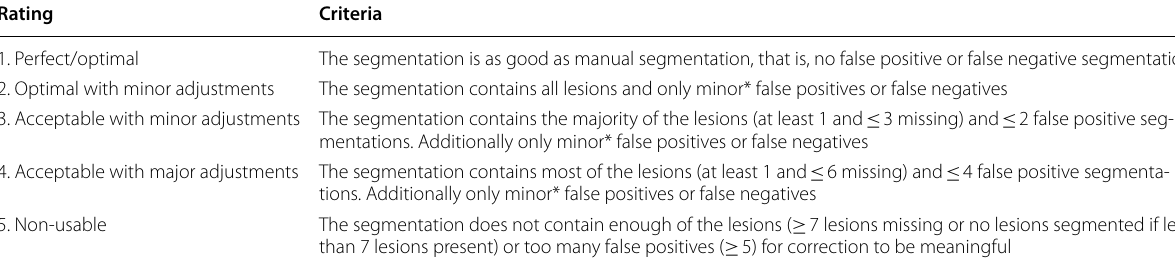
Table 1 Evaluation scheme of AI